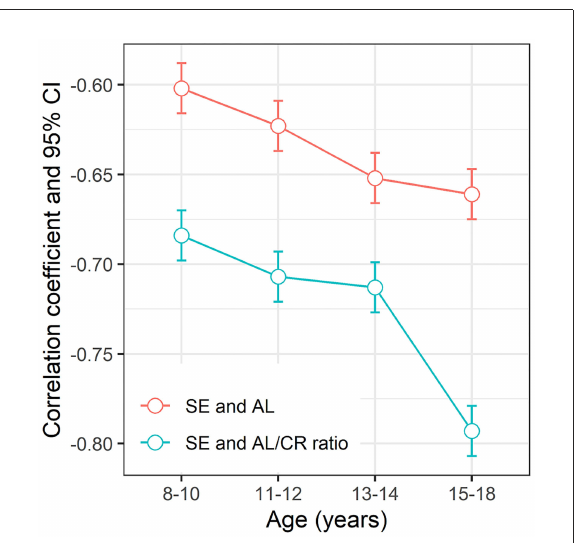
FIGURE3 The correlation coefficient and 95% CI between SE, AL/CR ratio, and AL among different refractive status groups. SE, spherical equivalent; AL, axial length; AL/CR ratio, axial length/corneal radius ratio; 95% CI, 95% confidence interval.